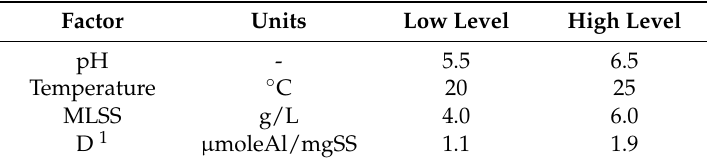
Table 4. Factors and levels for two-level alternative factorial design.